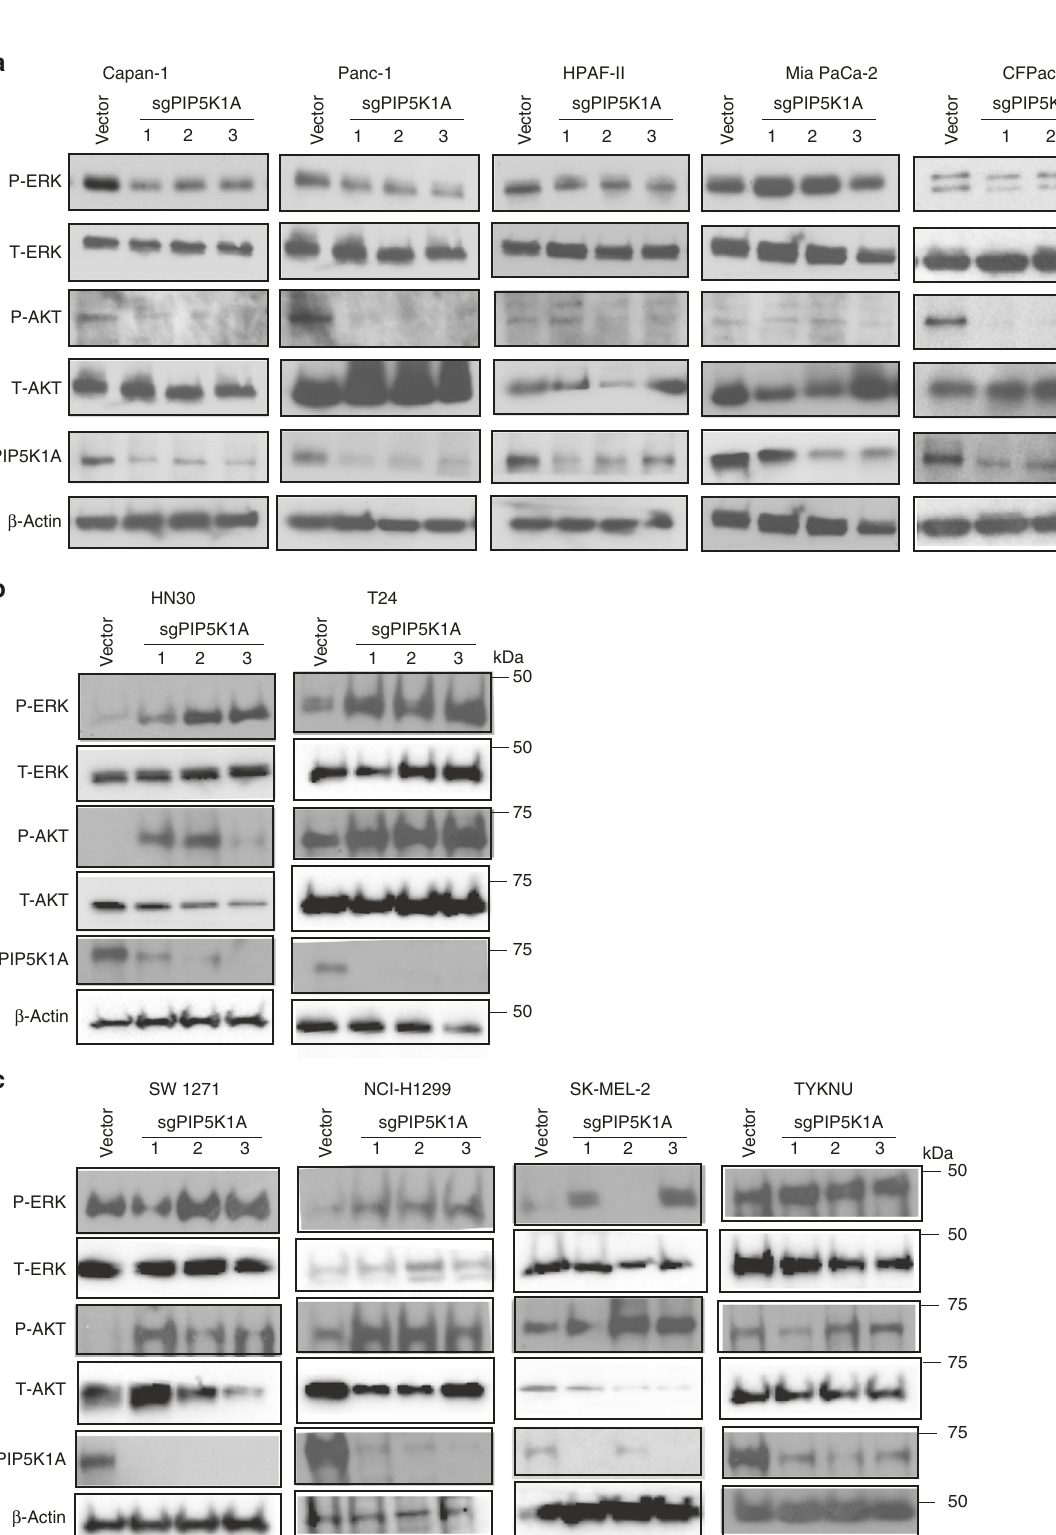
Fig. 5 PIP5K1A is an isoform-speci fi c vulnerability of KRAS -mutant cancer cells. Immunoblot detection of phosphorylated (P-) ERK and AKT in the indicated a KRAS -mutant, b HRAS -mutant, and c NRAS -mutant human cancer cell lines stably infected with a lentiviral vector encoding Cas9 and no transgene (vector) or one of up to three independent sgRNA targeting PIP5K1A (sgPIP5K1A-1 to -3) veri fi ed to reduce PIP5K1A expression. n = 2. Total (T-) ERK and AKT as well as β -actin serve as loading